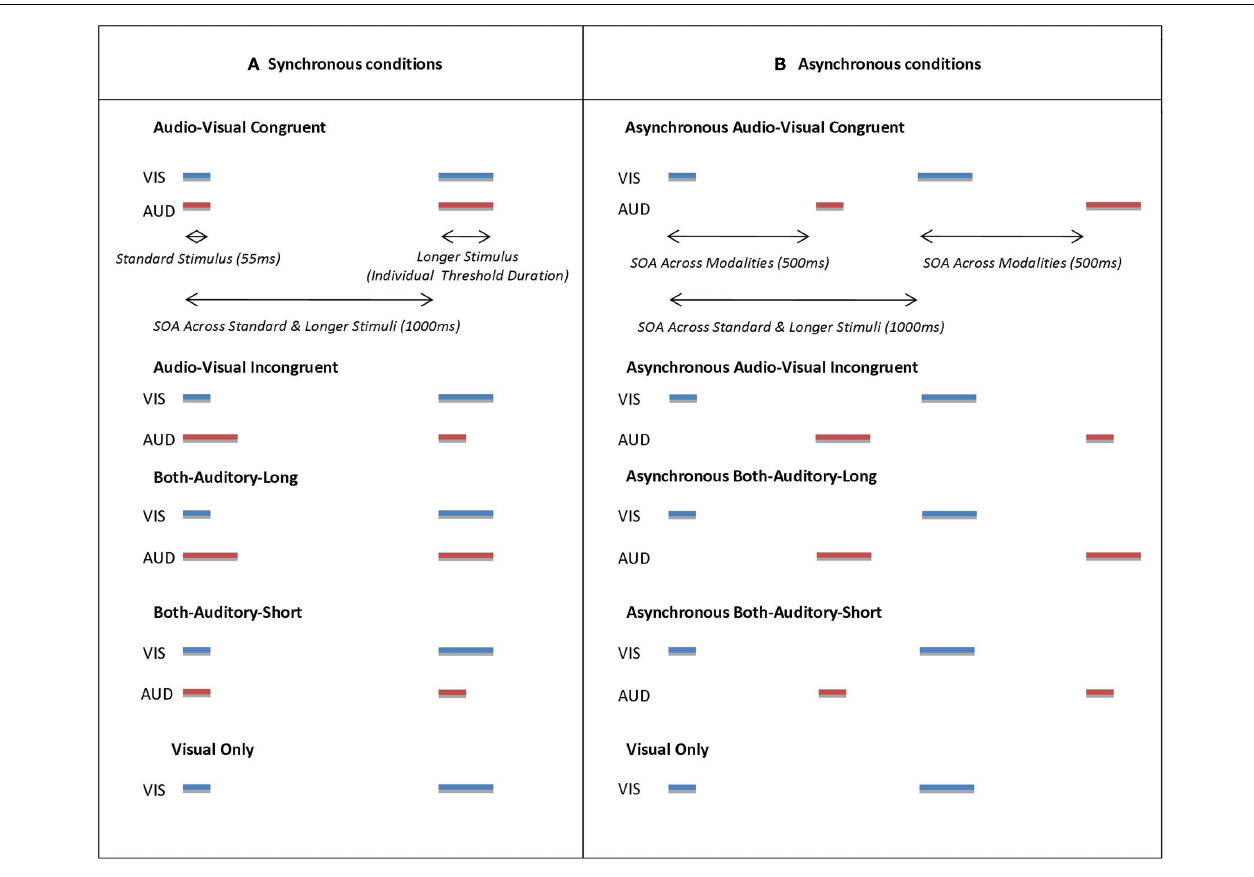
separated by a 1000-ms interval; the order of short and long stimuli could be the same across auditory and visual modalities (congruent) or reversed between them (incongruent). In the both-auditor-short condition, both successive sounds had the shorter visual duration (and vice versa for both-auditory-long). Finally a visual-only condition served as a baseline